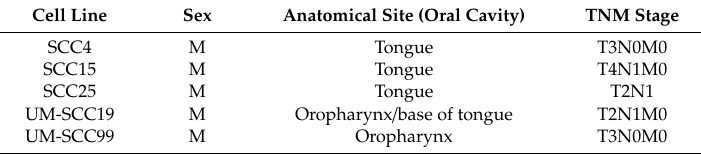
Table 1. Head and neck squamous cell carcinomas (HNSCC) cell lines used in this study. SCC4, SCC15, and SCC25 are from the oral cavity, while SCC19 and SCC99 are from the oropharynx. The basic characteristics for each cell line are listed